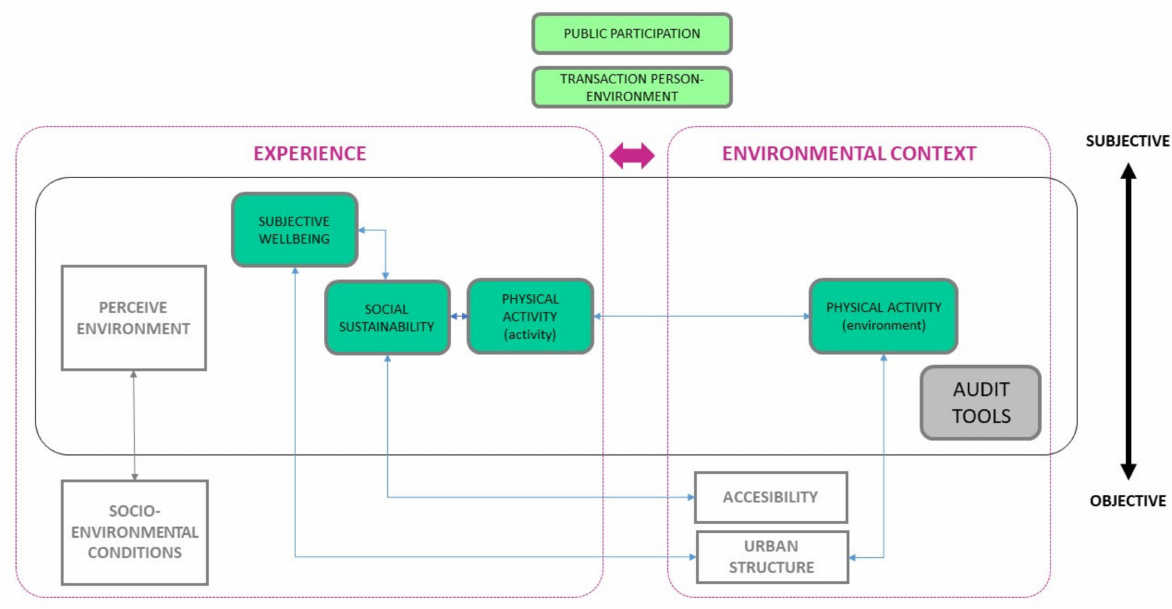
Figure 6. Conceptual framework to assess citizens’ perception of the built environment throughout digital